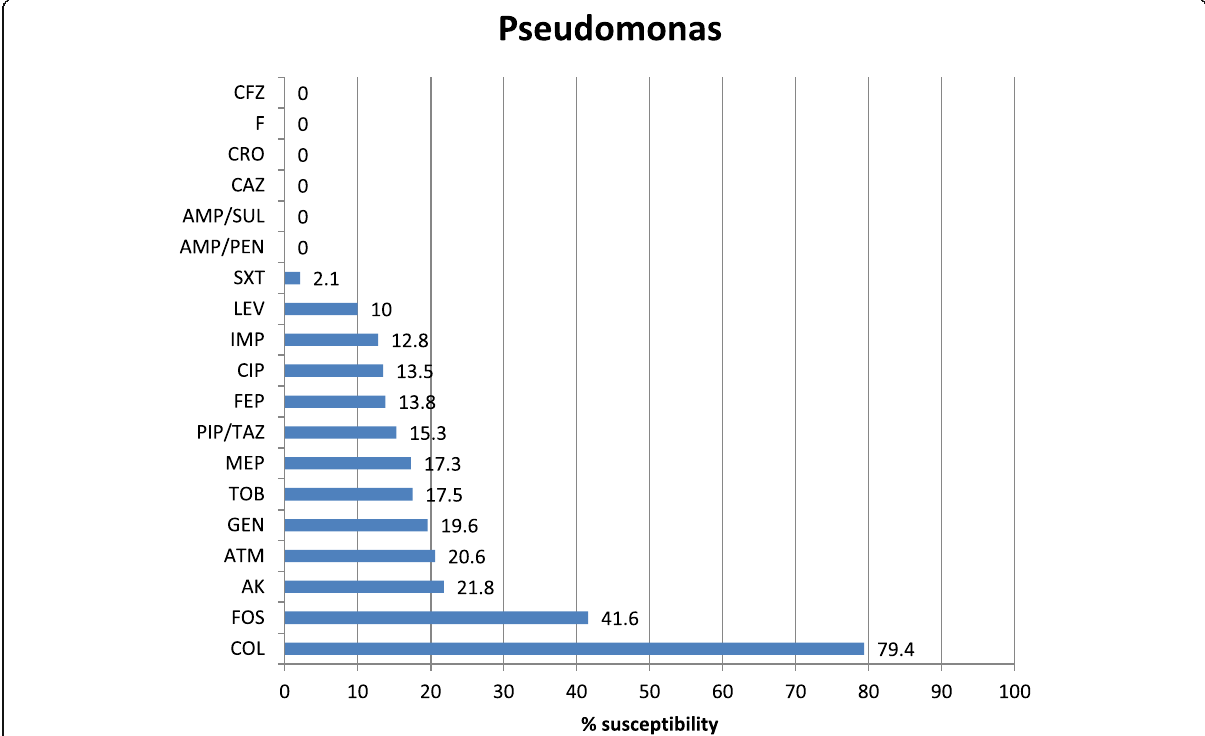
Fig. 5 Antibiotic susceptibility of Pseudomonas aeruginosa . Pseudomonas Pseudomonas aeruginosa . AMP/PEN ampicillin/penicillin, AMP/SUL ampicillin/sulbactam, PIP/TAZ pipracillin/tazobactam, CAZ ceftazidime, CRO ceftriaxone, FEP cefepime, ATM aztreonam, IMP imipenem, MEP meropenem, ERT ertapenem, GEN gentamycin, TOB tobramycin, AK amikacin, CIP ciprofloxacin, LEV levofloxacin, SXT sulfa-trimethoprim, COL